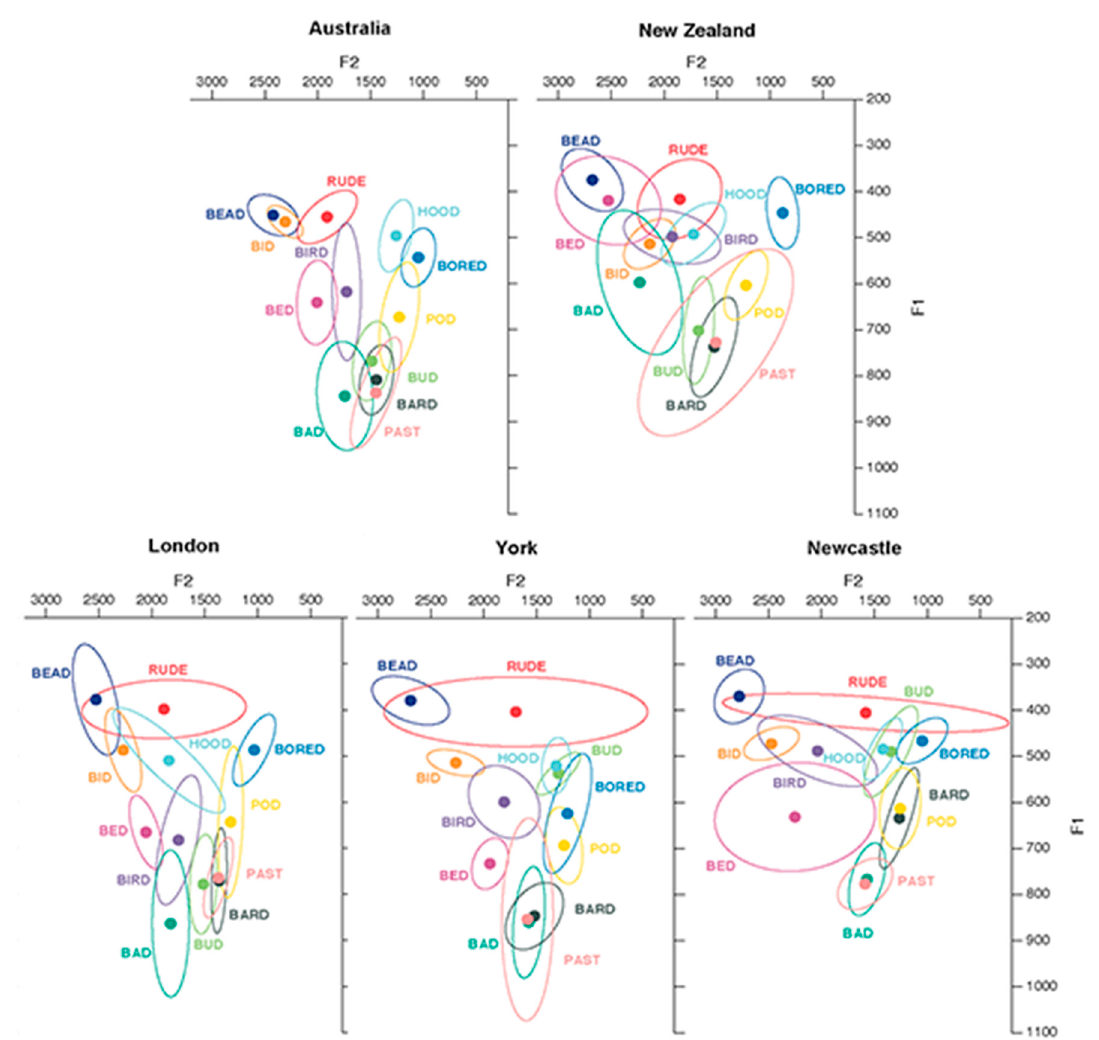
Figure 1. F1-F2 plot of vowels in Australian English (top left), NZE (top right), and three UK dialects (bottom) as reported in Shaw et al. (2018). F1 represents tongue height (high vs. low) while F2 represents tongue backness (front vs. back). For example, BEAD in the vowel plots depicts the tongue in the highest and furthest forward position in the mouth. (CC BY-4.0 https://creativecommons.org/licenses/by/4.0/, accessed on 12 February 2022).